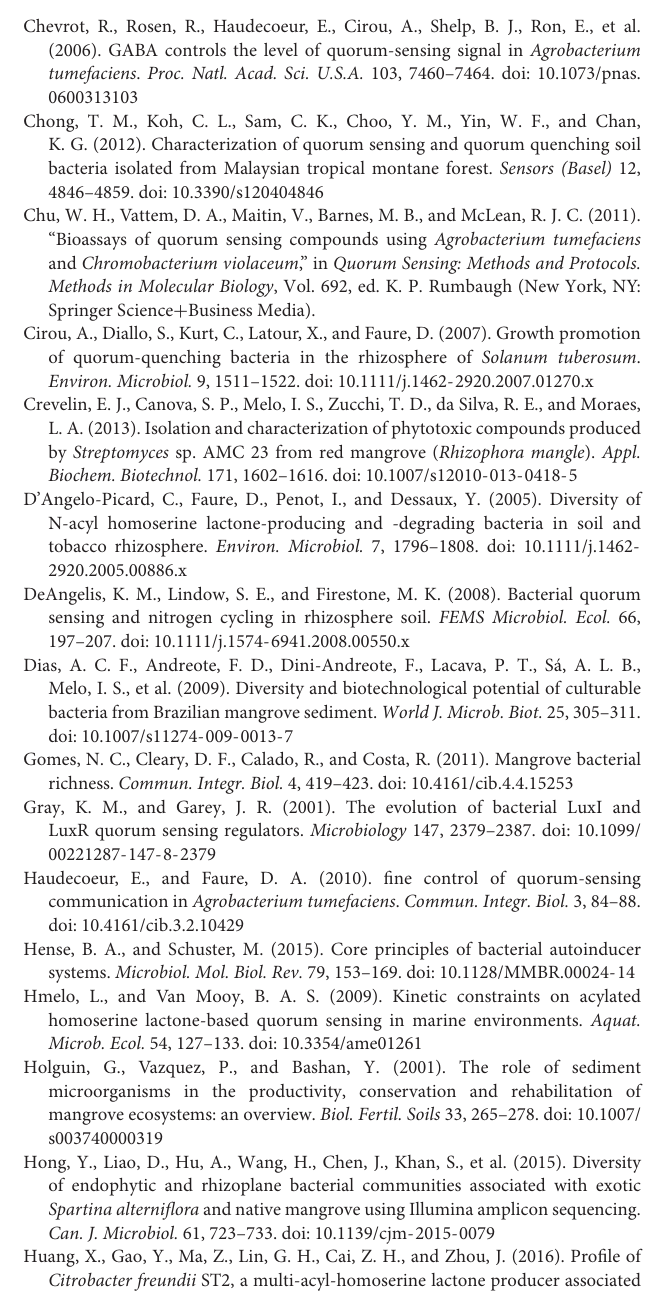
FIGURE S1 | Taxonomic composition of the root-associated microbiome of K. obovata from rhizosphere soil samples based on 16S rRNA sequencing. (A) Bacteria diversity at phylum level; (B) classes of Proteobacteria; and (C) the bacteria biodiversity at order level. The sequencing experiments were repeated three